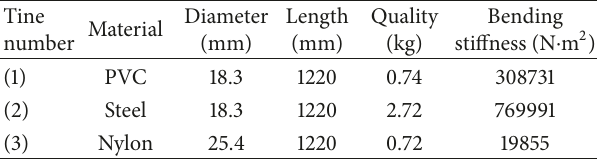
Figure 5: Accelerometer fixing methods on branches and stems. Table 1: Physical properties of shaking